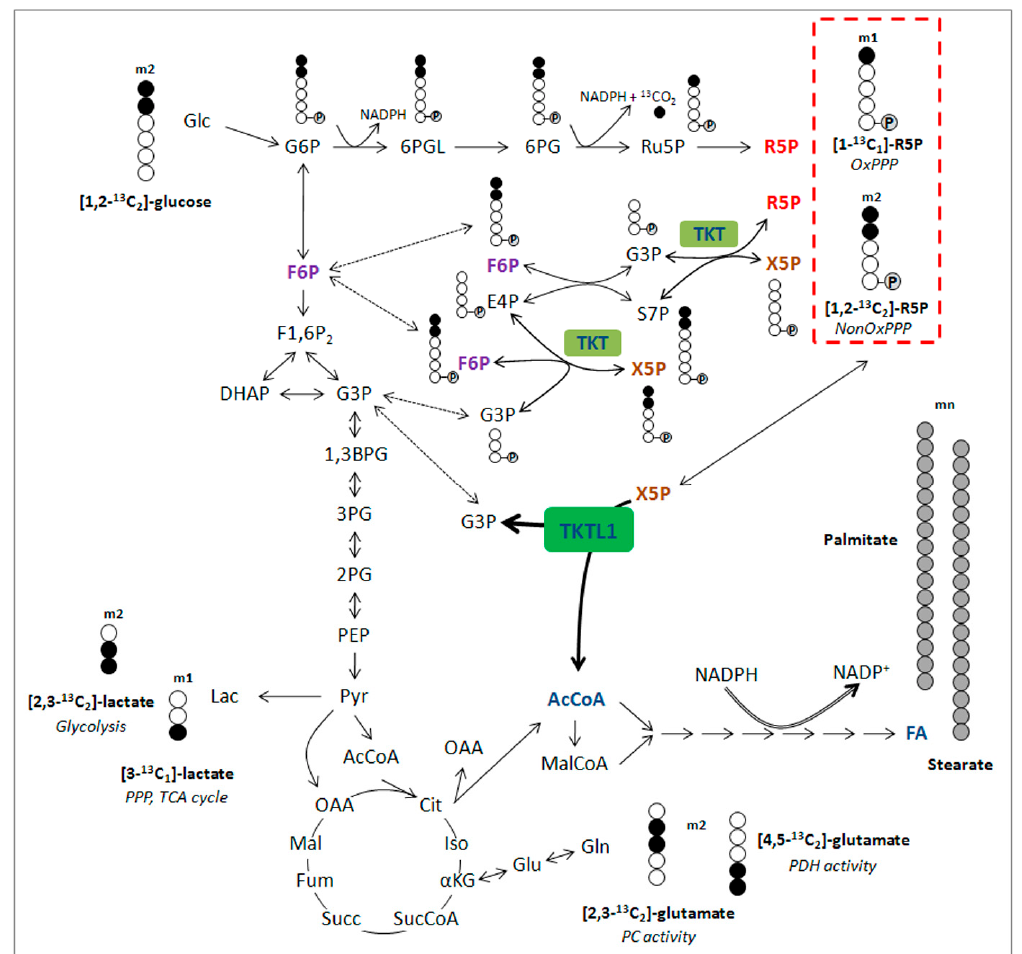
Figure 1. Overview of isotopomer formation through carbon distribution of [1,2- 13 C 2 ]-glucose. Distribution of carbon atoms from [1,2- 13 C 2 ]-glucose results in the presence of different kinds of isotopomers from lactate, glutamate and ribose-5-phosphate and reflect the involvement of specific pathways (italic). Ribose-5-phosphate incorporating 3, 4 or 5 13 C atoms (m3, m4 and m5) is generated through recirculation of labeled molecules in the pentose phosphate pathway PPP. Carbons are represented by circles. Filled circles represent carbons that have incorporated label form [1,2- 13 C 2 ]-glucose, open circles represent unlabeled carbons. Circles containing P represent phosphate groups.